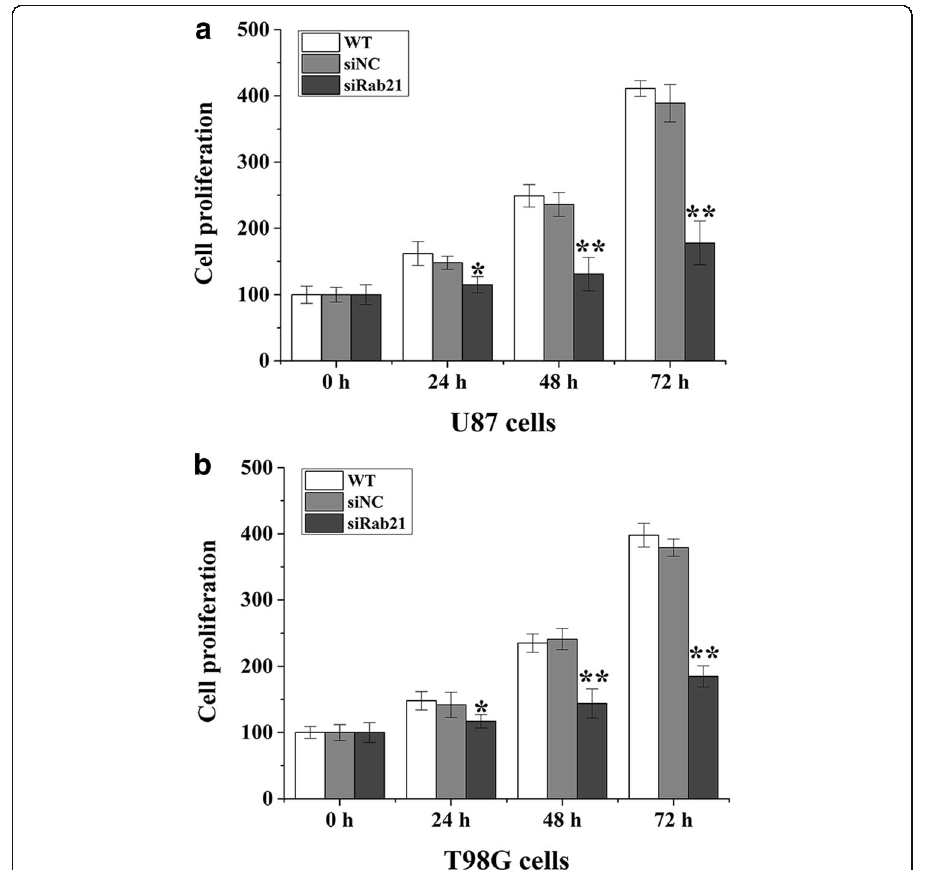
Fig. 3 Rab21knockdown inhibits glioma cell proliferation. Human Rab21siRNA were transfected into T98G ( a ) and U87 ( b ) cells, followed by cell proliferation determination using the CCK-8 assay. The results of cell proliferation were normalized to the initial cell numbers (100%). * p <0.05,** p <0.01 compared with the siNC